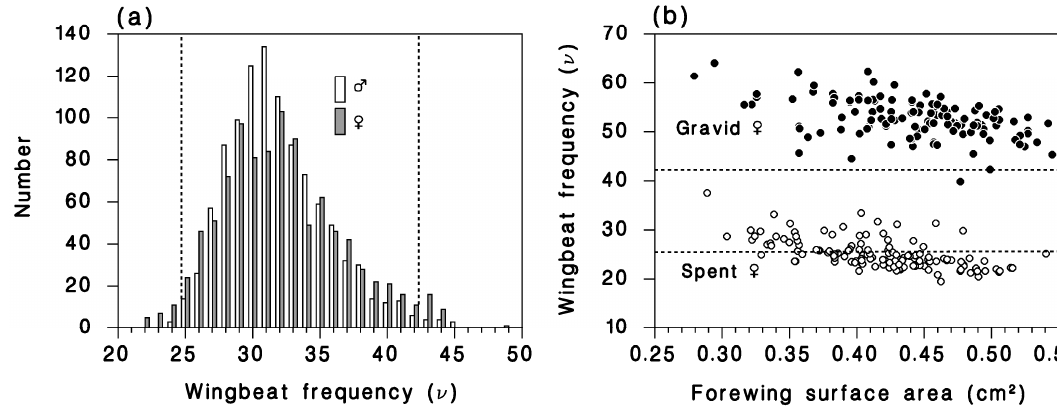
Figure 6. Liftoff wingbeat frequencies calculated from dry weight and forewing surface area with Equation (8) using K = 167.5 Hz. ( a ) Distribution of wingbeat frequencies of male and female moths caught in canopy traps. Vertical dotted lines: observed range of wingbeat frequencies of migrating budworm moths ( ν = 25–42 Hz according to the authors of [9]). ( b ) Liftoff wingbeat frequencies of fully gravid ( ● ) and spent ( ○ ) females from observations at Lac des Huit-Milles, 1989–1990.